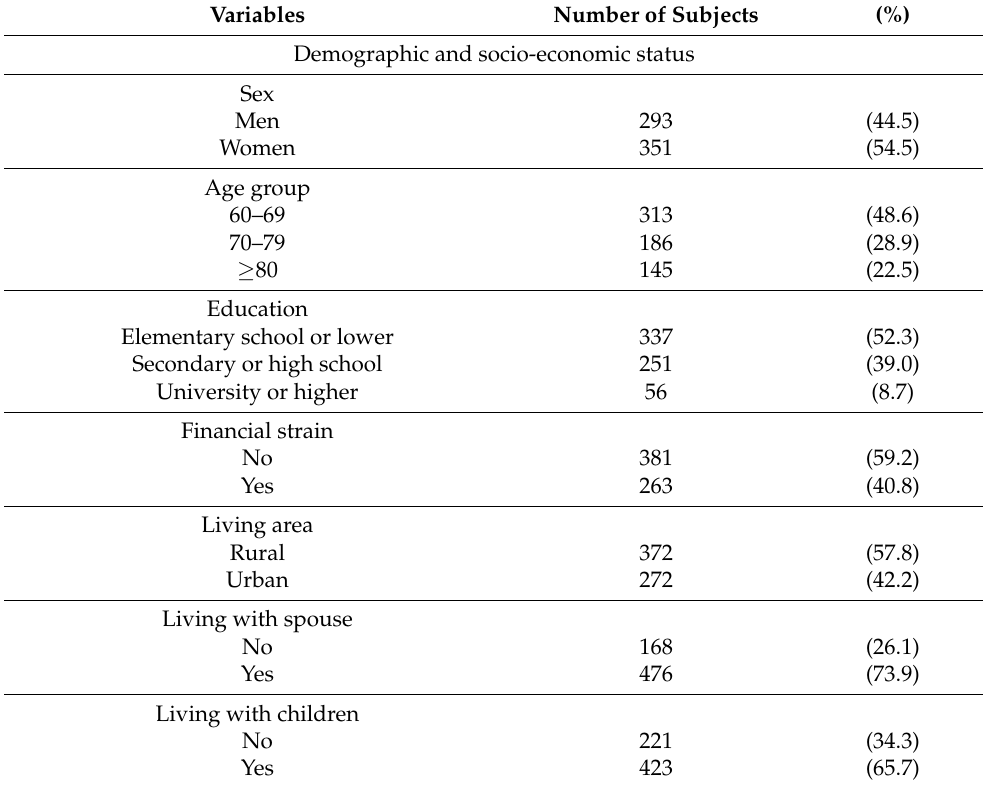
Table 1. Characteristics of study participants included in the analysis ( n =